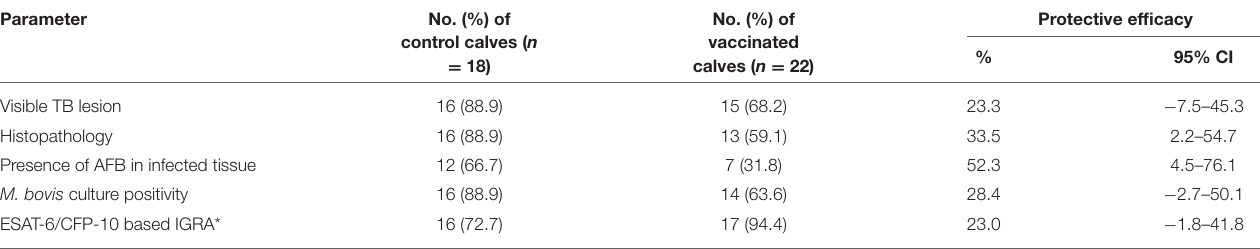
TABLE 1 | Protective efficacy of the BCG against bTB in HF × Zebu crossbred BCG-vaccinated and control calves after 1 year of exposure to SICCT test positive cows.